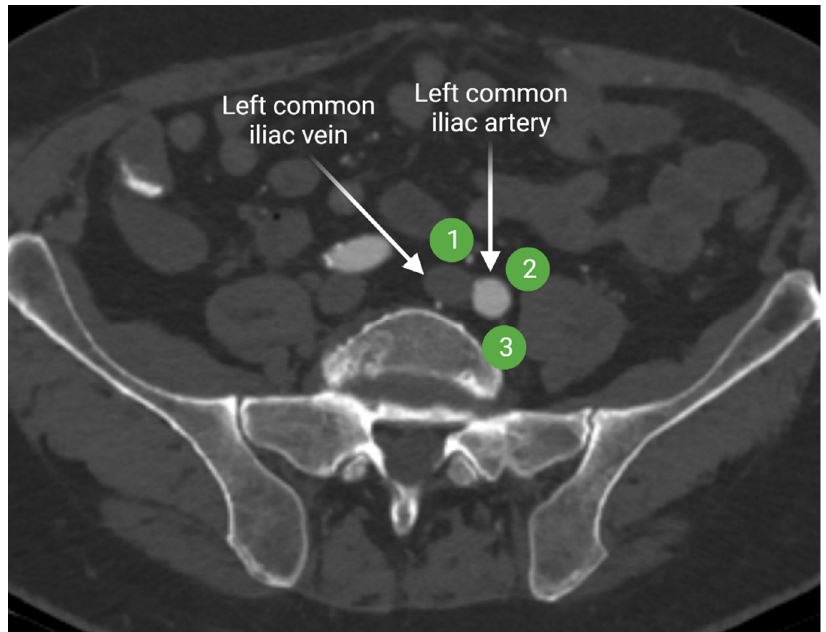
Figure 5. Axial contrast-enhanced CT of the upper pelvis at the level of the common iliac vessels shows the common iliac artery and vein. The lateral common iliac lymph node subgroup ( 1 ) is located lateral to the common iliac artery, while the medial subgroup ( 2 ) is medial to the common iliac artery. The middle subgroup ( 3 ) is in the lumbosacral fossa. “Created by BioRender.com. accessed on 10 August 2021”.